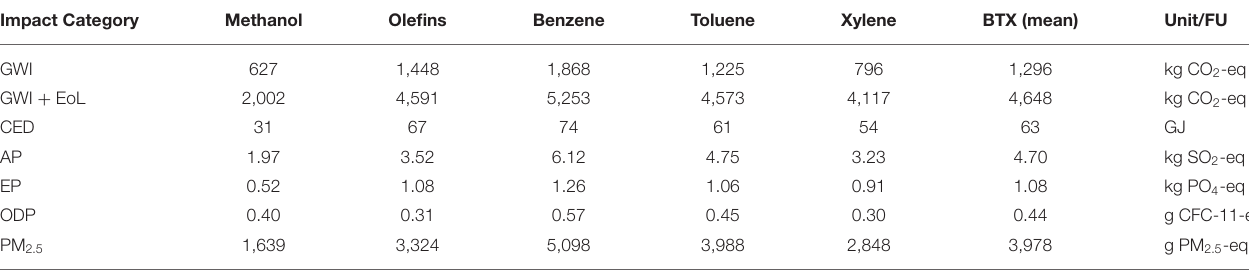
TABLE 4 | Environmental impacts of 1,000kg fossil reference products.